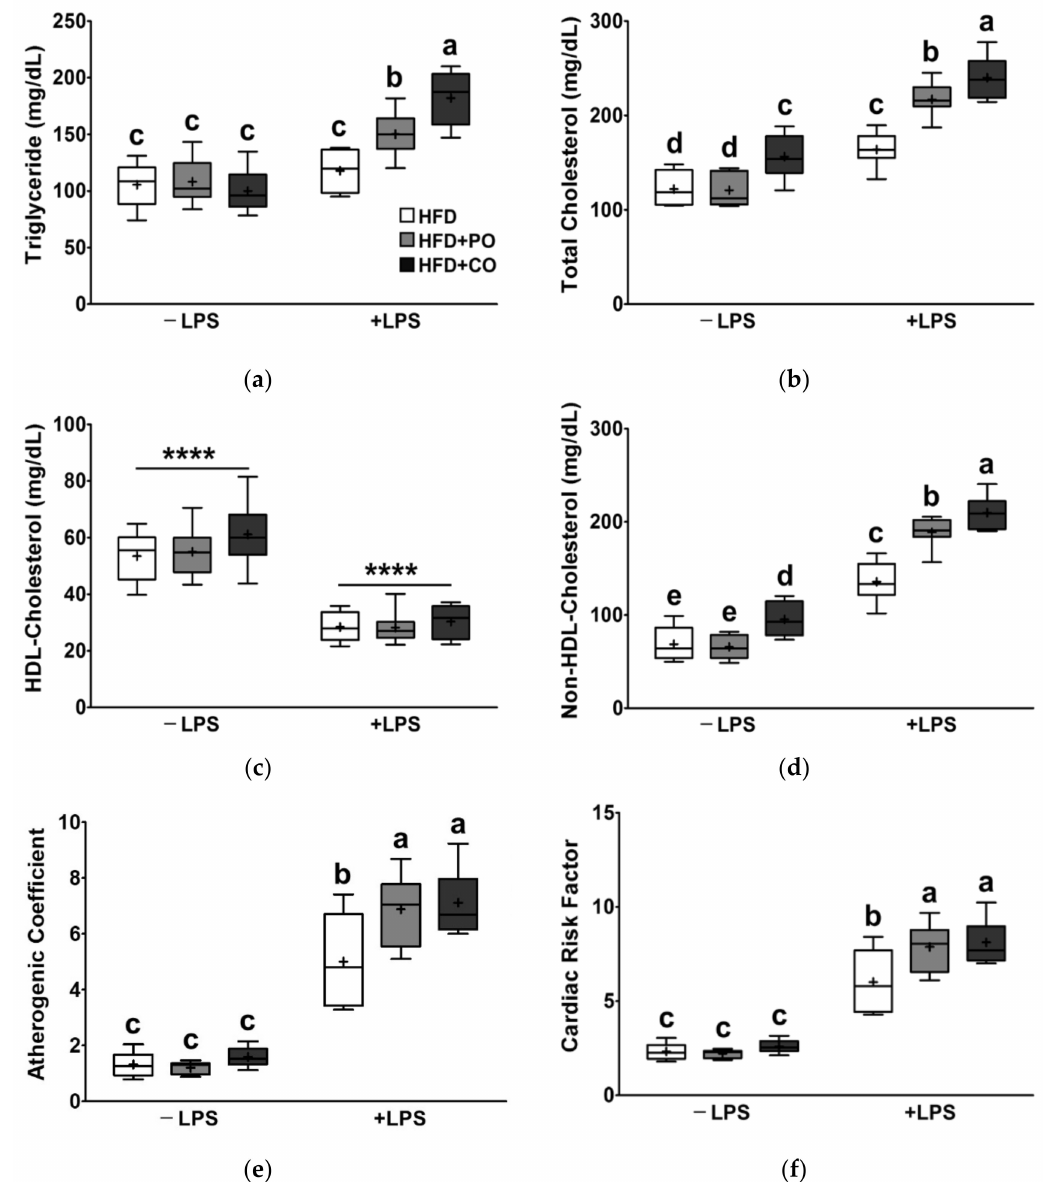
Figure 4. Effects of partial replacement of dietary fat with PO or CO and LPS stimulation on the serum lipid profile. Five-week-old male Sprague-Dawley rats were fed either the HFD, HFD + PO, or HFD + CO for 12 weeks and then treated with PBS or LPS (5 mg/kg) for 24 h ( n = 8 per group). ( a ) Serum triglyceride (TG) level; ( b ) serum total cholesterol (TC) level; ( c ) high-density lipoprotein (HDL)-cholesterol level; ( d ) non-HDL-cholesterol level; ( e ) atherogenic coefficient; ( f ) cardiac risk factor. Data were analyzed using two-way ANOVA and Tukey’s multiple comparisons post hoc test for multiple comparisons. Means with different letters indicate significant differences at p < 0.05. Asterisk indicates a significant main effect for LPS (**** p < 0.0001). LPS, lipopolysaccharide; PBS, phosphate-buffered